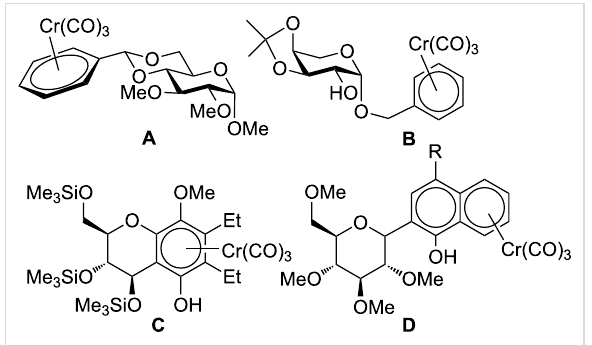
Figure 1: Known types of η 6 -tricarbonylchromium complexes of sugar derivatives